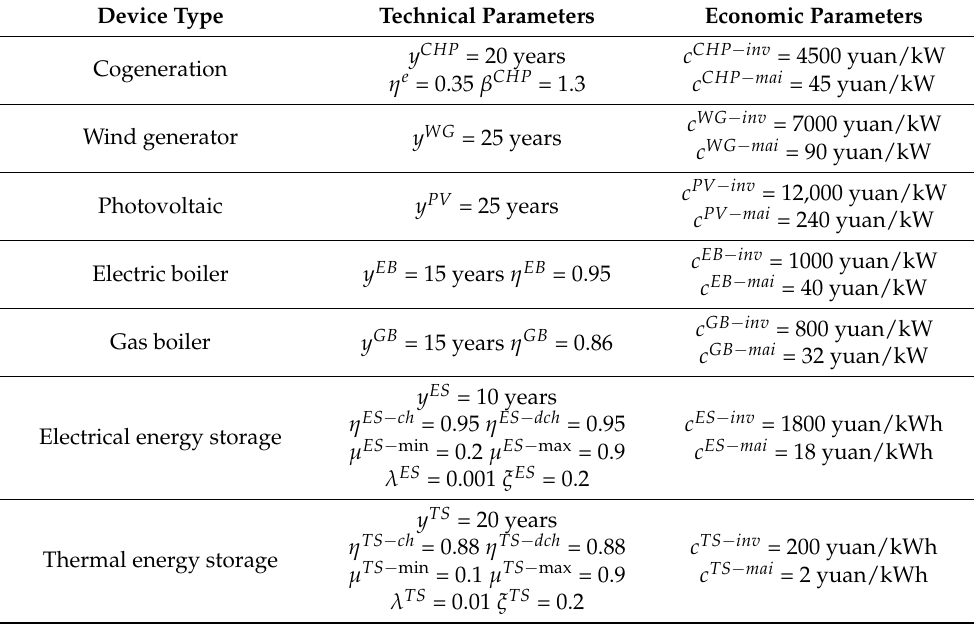
Table 1. Parameters of EH